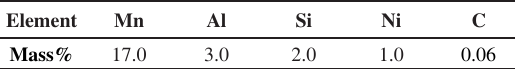
Table 1. Chemical composition of TRIP/TWIP a